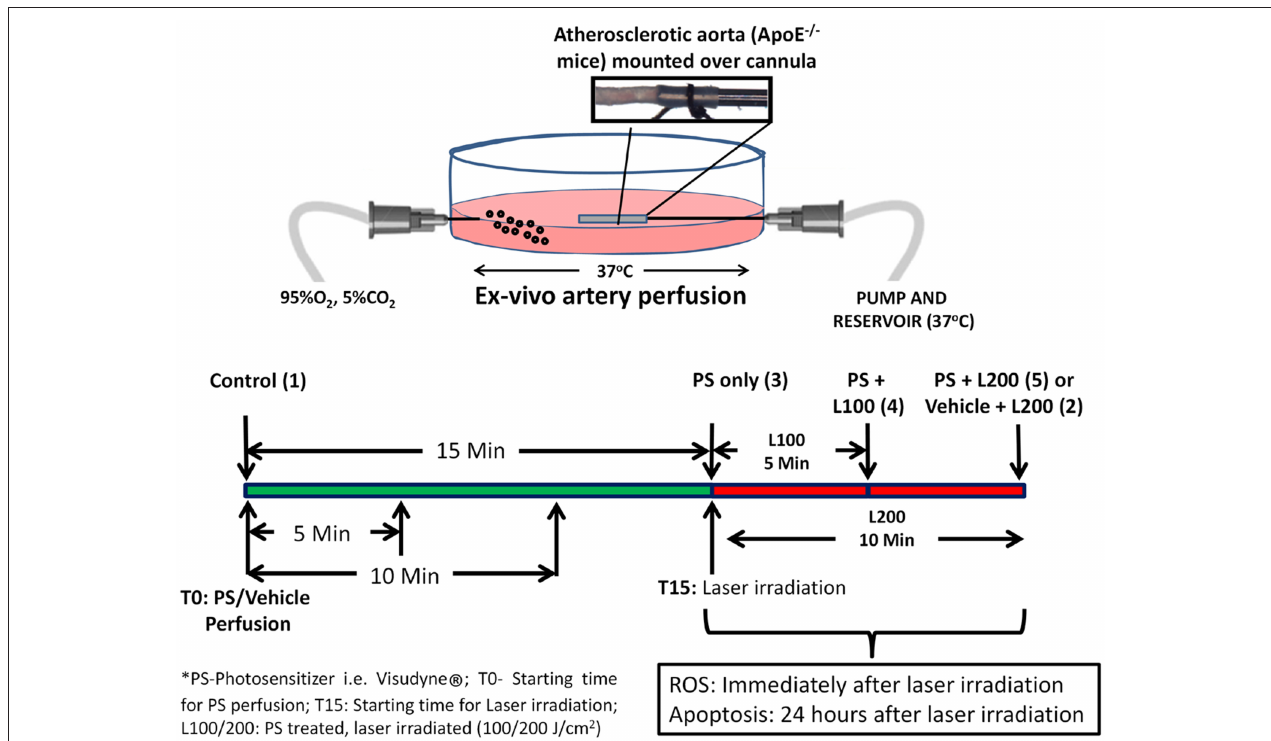
FIGURE 1 | Schematic representation of the ex-vivo artery perfusion system where atherosclerotic aorta, isolated from ApoE − / − mice, was mounted over a cannula and perfused with vehicle or Visudyne ® for 5–30min. Laser irradiation at 100 or 200J/cm 2 was performed immediately after perfusion. ROS level and apoptosis was monitored immediately or after 24h of laser irradiation